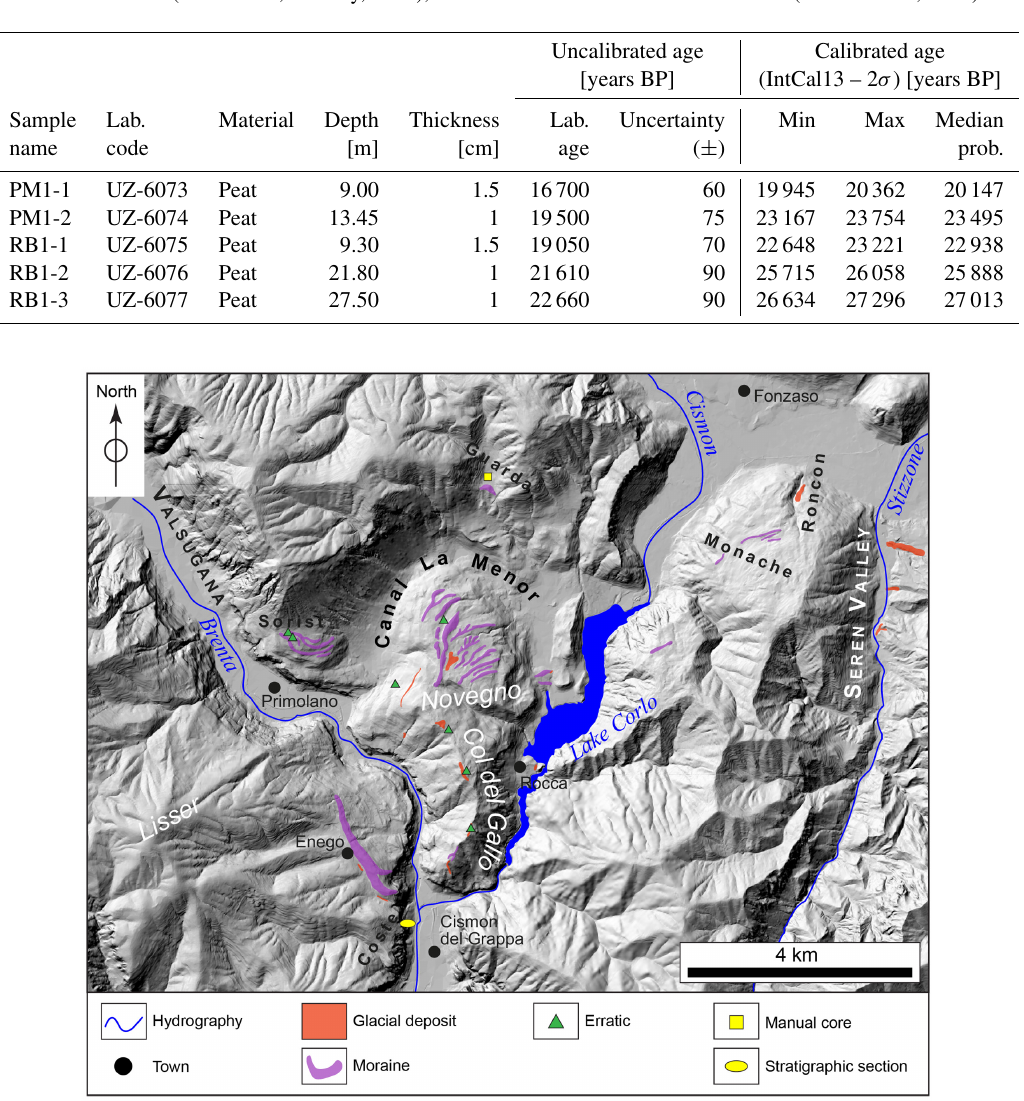
Figure 2. Outcrops map of the middle Valsugana sector derived from field surveys and remote sensing data. Polygons/symbols overlie a 5m cell DTM (modified from data distributed by Regione Veneto; source: http://idt.regione.veneto.it/app/metacatalog/, last access: 13 April